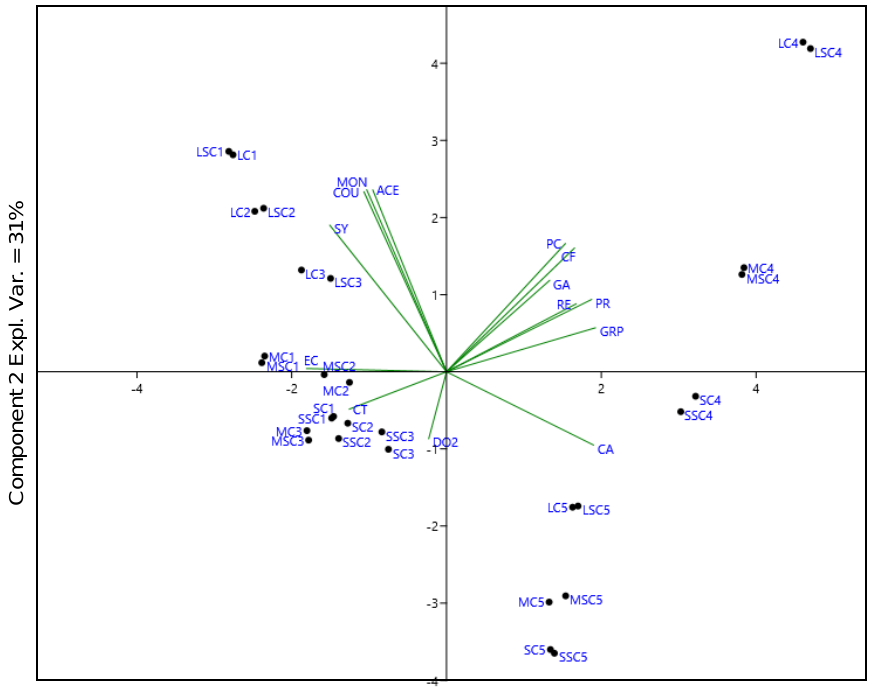
Figure 1. PCA bi-plot (% explained total variance: PC-1, 42%; PC-2, 31%) of the three red wines closed with di ff erent stoppers considering the phenolic profiles and the dissolved oxygen (DO 2 ) during 12 months of bottle storage. Samples: SC and SSC, St. Magdalener closed with conventional stopper or ‘blend’ stopper, respectively. LC, LSC, Lagrein with conventional or ’blend’ stopper, respectively; MC, MSC, Merlot. Storage in bottle: 1, wine just after bottling; 2,3,4,5, wine analyzed one, three, six 12 months after bottling, respectively. Phenolic compounds: MON, non-acylated anthocyanins; ACE, acetylated anthocyanins; COU, coumaroylated anthocyanins; GA, gallic acid; PR, protocatechuic acid; GRP, glutathionyl caftaric acid; CA, caftaric acid; CF, ca ff eic acid; CT, catechin; EC, epicatechin; SY, syringic acid; PC, p -coumaric acid; RE,